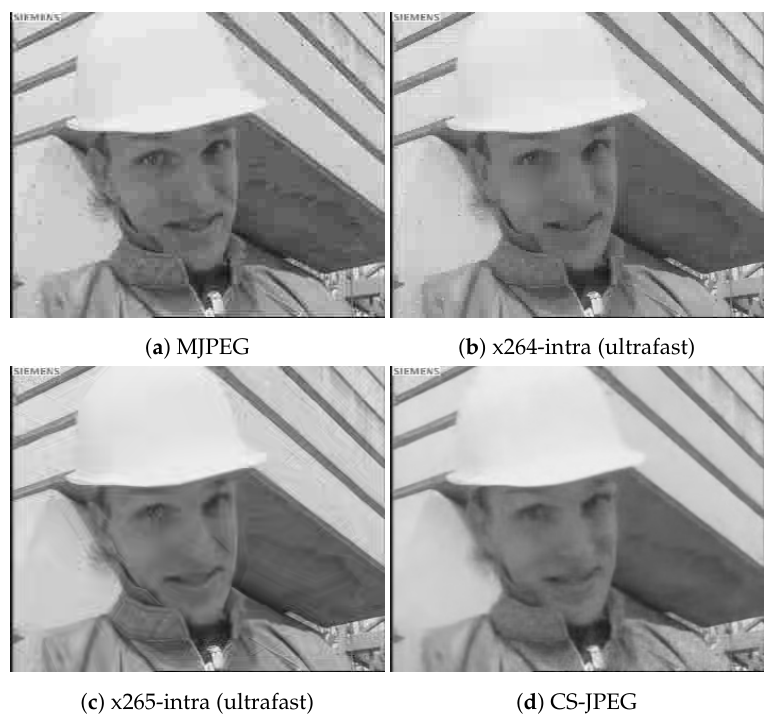
Figure 13. Frame with index 150 at R T = 600 kbps for ‘Foreman’.